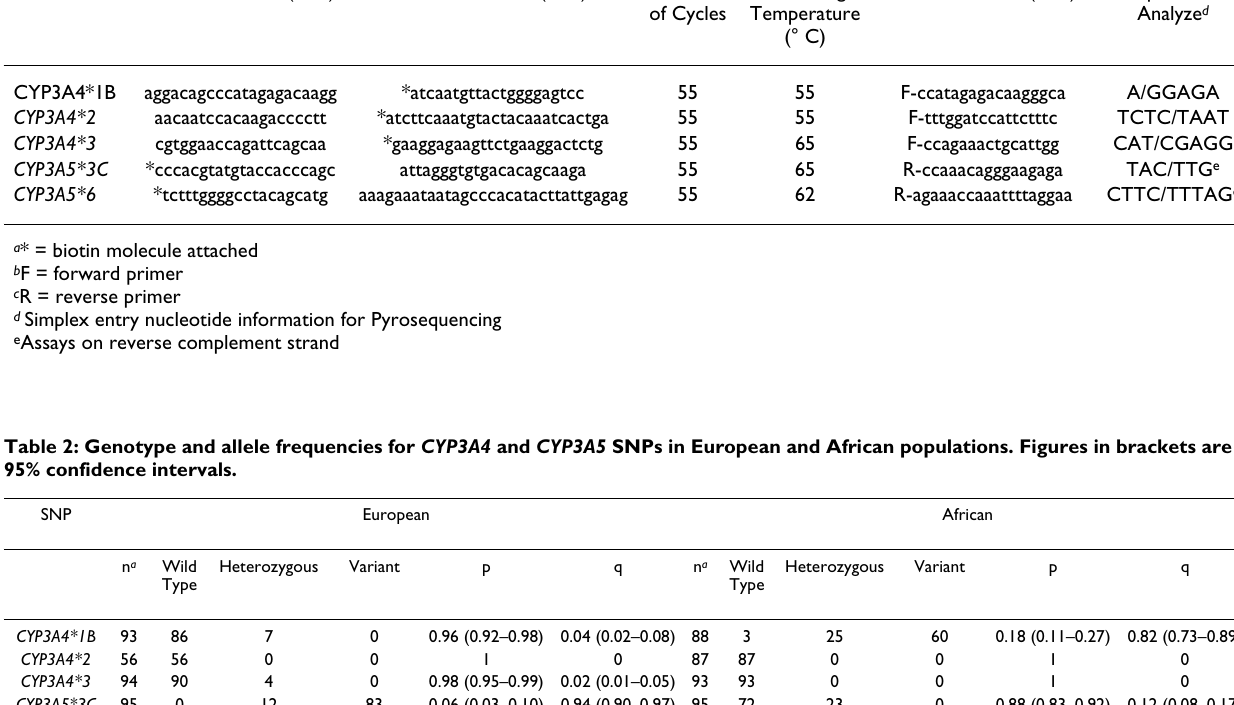
Table 1: Primer sequence, PCR and Pyrosequencing conditions for CYP3A4 and CYP3A5 SNP analysis. SNP Forward Primer a (5'-3') Reverse Primer a (5'-3')